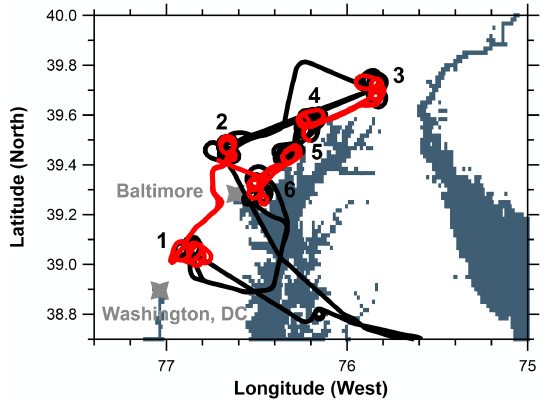
Figure 1. Flight path for flight 1. Portions below 1km are shown in red, and those above in black. Flights originated at NASA Wal- lops Flight Facility (southeast of the area shown) to ground sites 1 through 6 in order, with a spiral performed at each site. The cir- cuit was typically flown three times per flight before returning to Wallops. Water is denoted as blue, with the Chesapeake Bay at the center and the Delaware Bay on the right